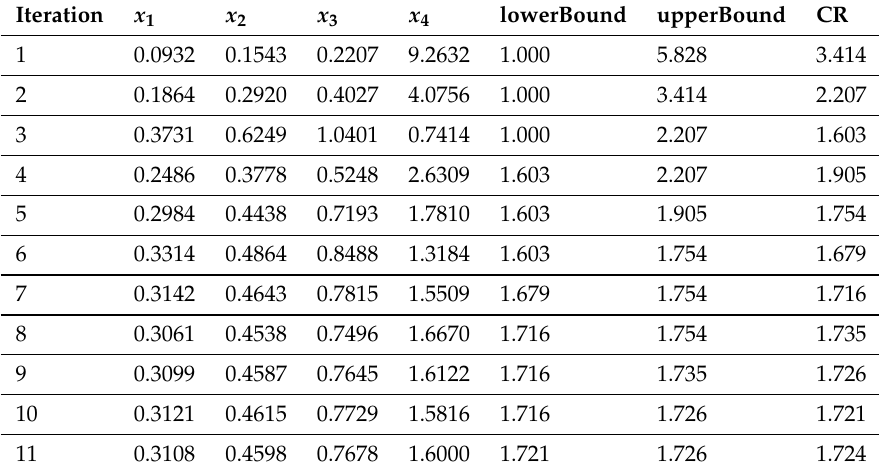
Table 4. Sample run of Algorithm 1: for each iteration, the current competitive ratio (CR) together with the the corresponding online algorithm for that ratio (defined by switching time values x i ) is